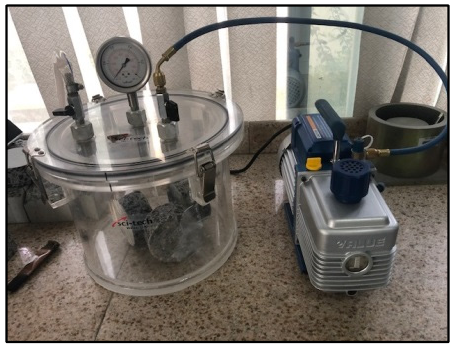
Figure 4. J-ring flow test.